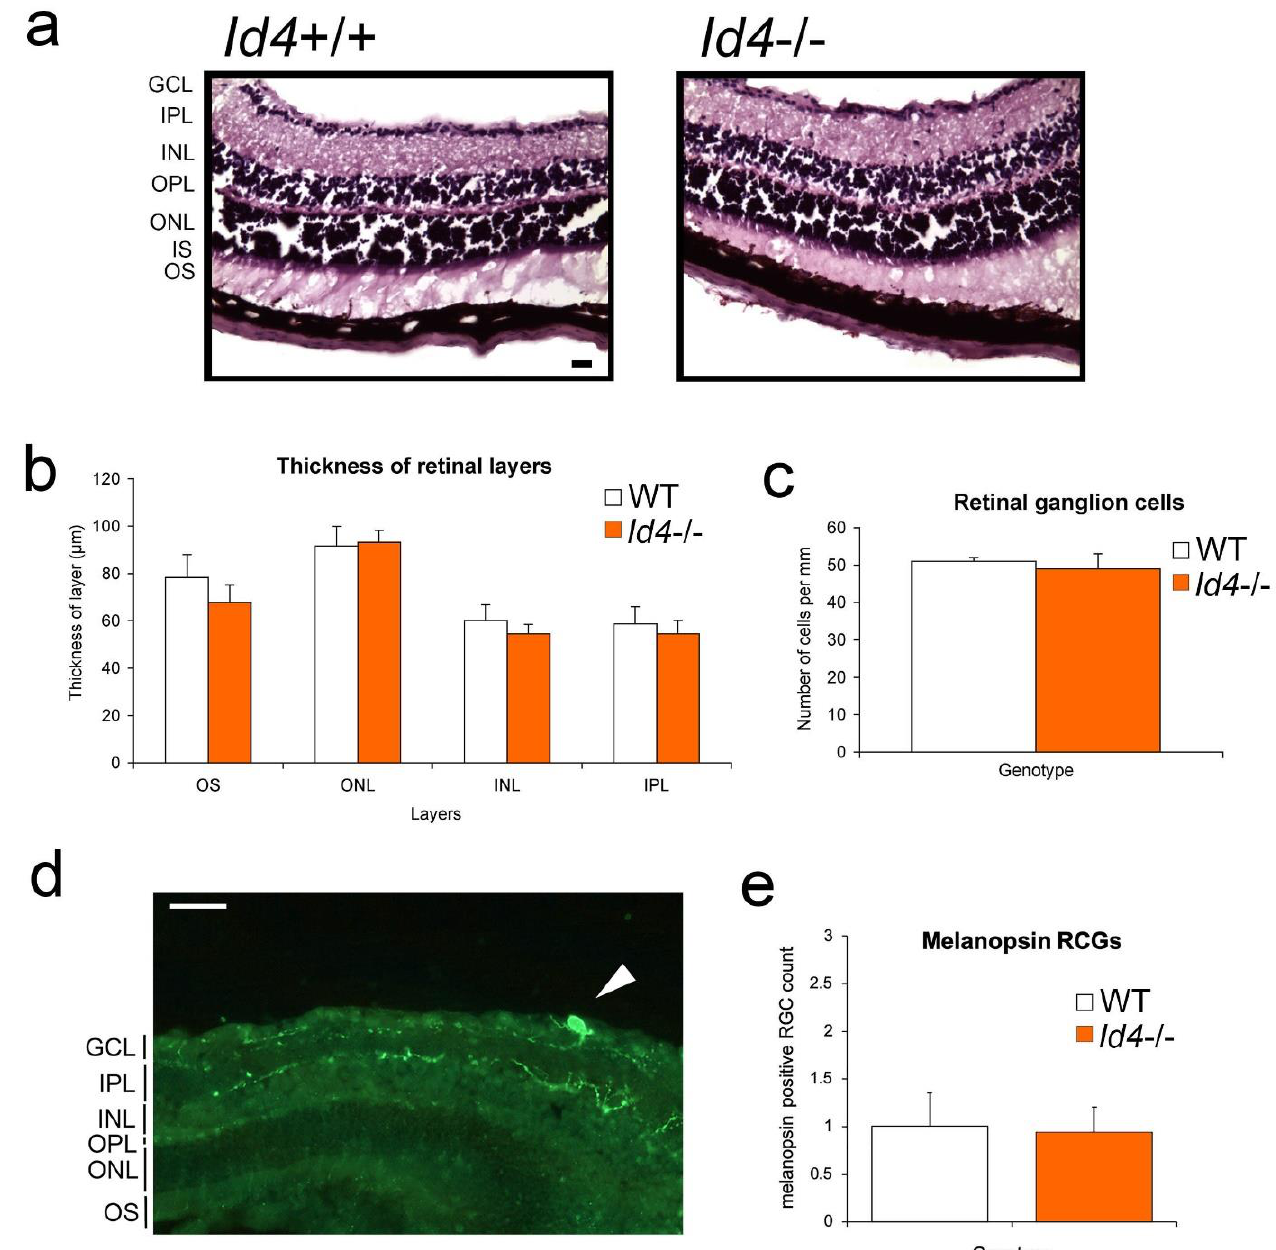
Figure 7. Retinal anatomy compared between Id4 − / − and wild-type ( Id4 +/+, WT) mice. ( a ) Cresyl violet-stained 16 µ m sections through representative wild-type and Id4 − / − mouse retina showing layers. GCL, ganglion cell layer; IPL, inner plexiform layer; INL, inner nuclear layer; OPL, outer plexiform layer; ONL, outer nuclear layer; IS, inner segment; OS, outer segment layer. Scale bar = 20 µ m. ( b ) Retinal layers were measured in µ m. Mean ± SEM of retinal layers are shown, and differences between genotypes for each layer assessed by t-test (n.s.). ( c ) Number of retinal ganglion cells (RGCs) was counted per 1 mm length of retina. No significant difference was detected between genotypes in either the thickness of layers or in the number of RGCs (wild type (WT; white), n = 4; Id4 − / − (orange), n = 6). ( d ) Melanopsin immunostaining in the retina. Representative fluorescent immunostaining of melanopsin cell soma (arrow) in the RGC layer of an Id4 − / − mouse with neuron projection into the IPL. In addition, in this image are melanopsin-positive fibers present in the GCL and INL. Scale bar = 50 µ m. ( e ) Number of melanopsin-positive RGCs (cell soma) was counted per 1 mm length of retina. Mean ± SEM number of cells is shown (wild type, n = 4; Id4 − / − , n = 6), and no significant difference was detected between genotypes in the number of